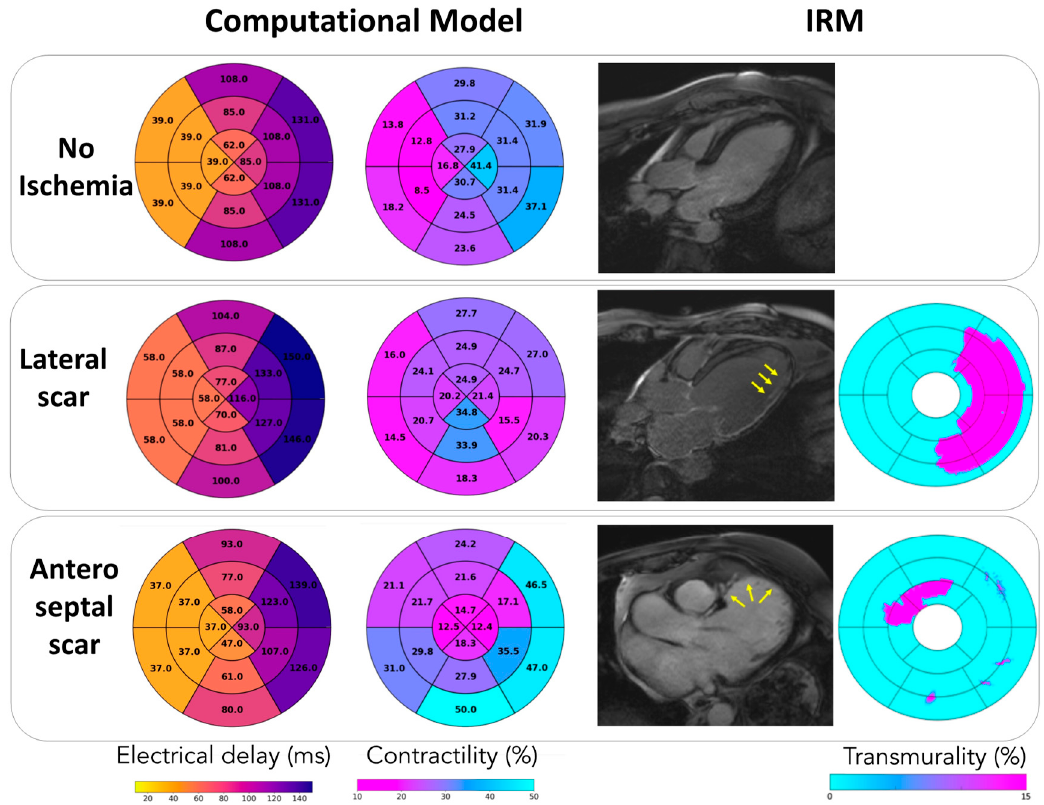
Figure 5. Contractility levels (%), electrical delays (ms) estimated with the model-based approach, and transmurality degree (%) in ischemic patients obtained by